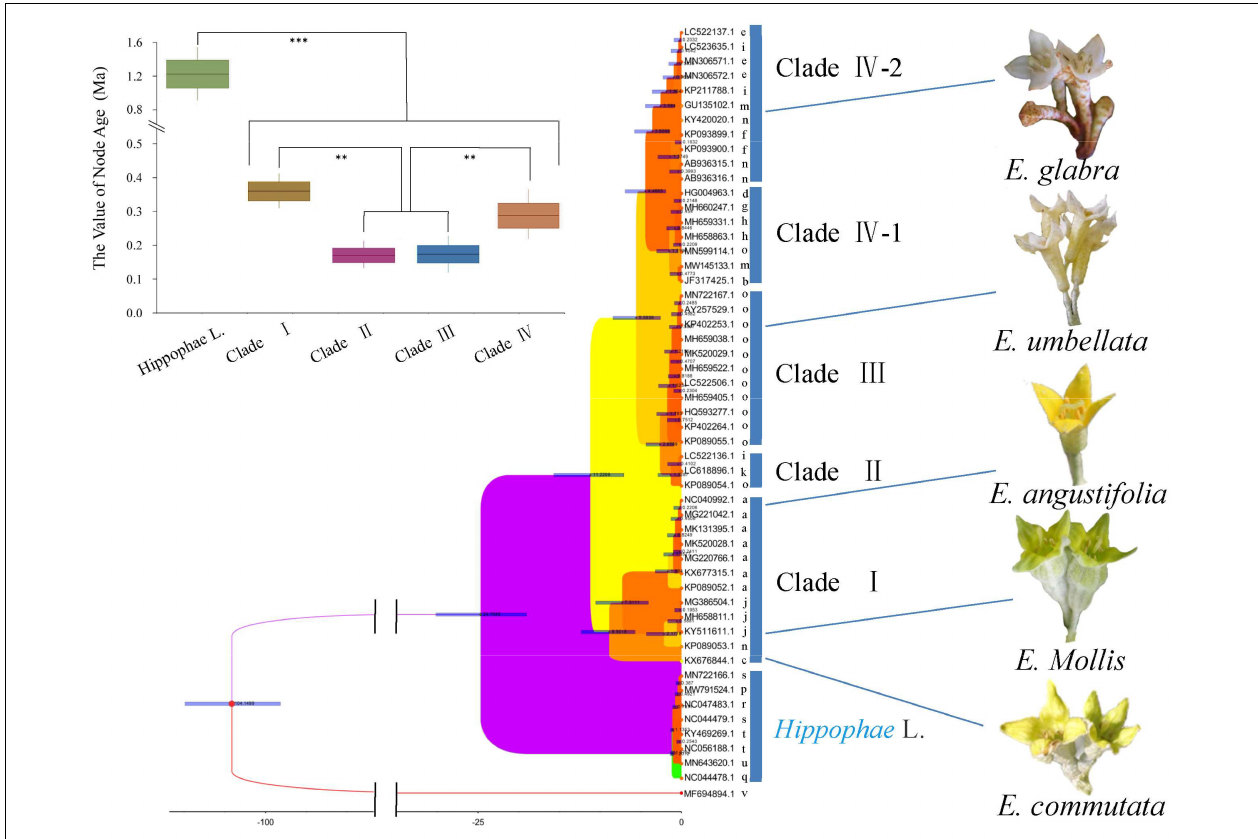
FIGURE 5 | Time-calibrated Bayesian tree inferred from the matK sequences of the family Elaeagaceae and one outgroup species of Acer using BEAST. t -test, *** p < 0.001 and ** p <